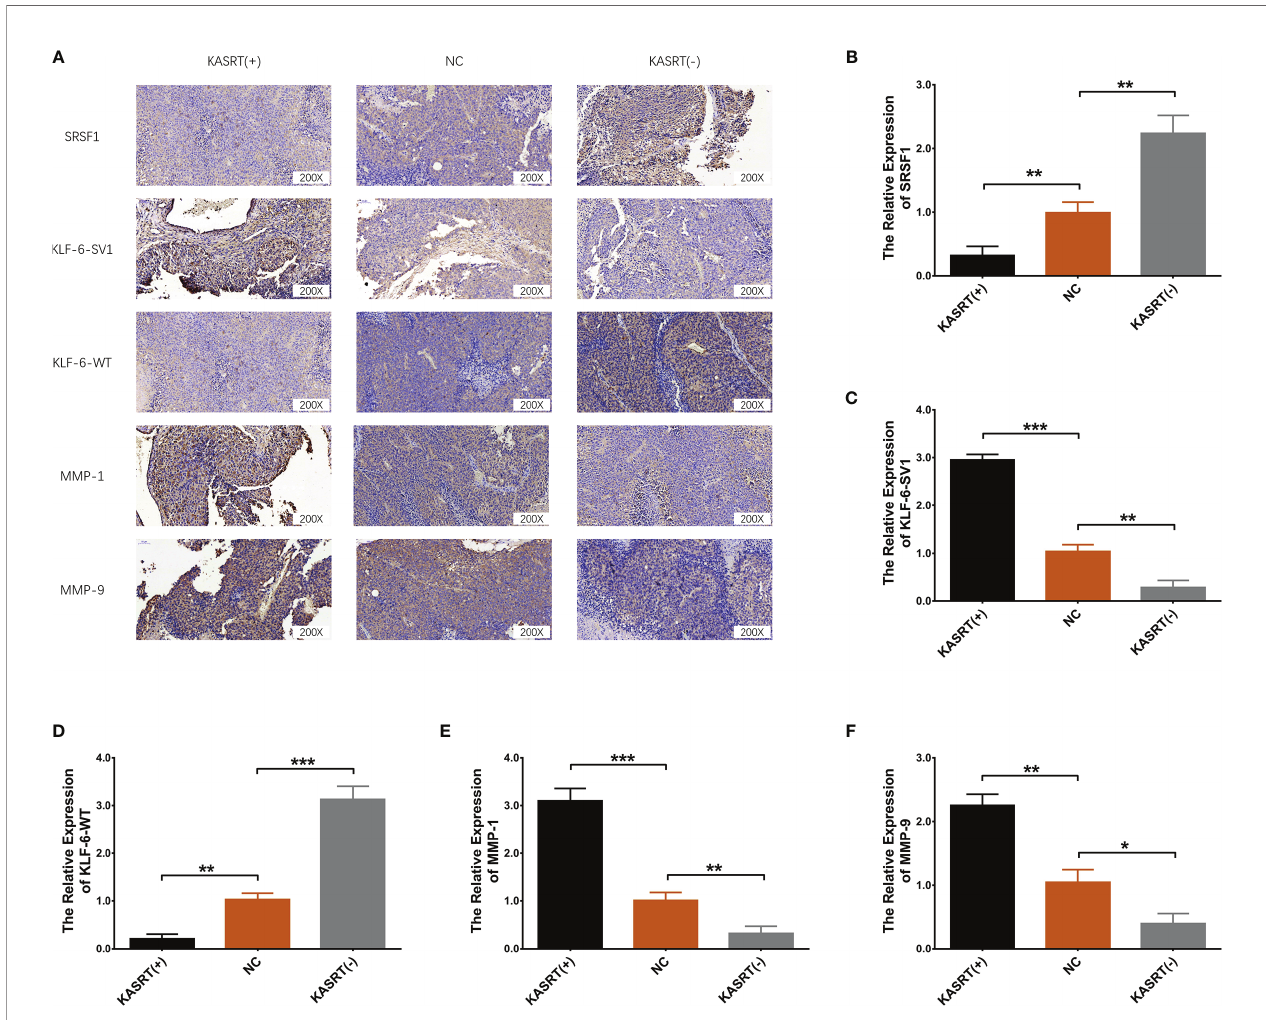
FIGURE 10 | SRSF1, KLF6-SV1, KLF6-WT, MMP1, and MMP9 expression in osteosarcoma tissue. Protein expression of SRSF1, KLF6-SV1, KLF6-WT, MMP1, and MMP9 in osteosarcoma tissue (A) . mRNA expression of SRSF1 (B) , KLF6-SV1 (C) , KLF6-WT (D) , MMP1 (E) , and MMP9 (F) in osteosarcoma tissue. *P < 0.05, **P < 0.01, ***P <